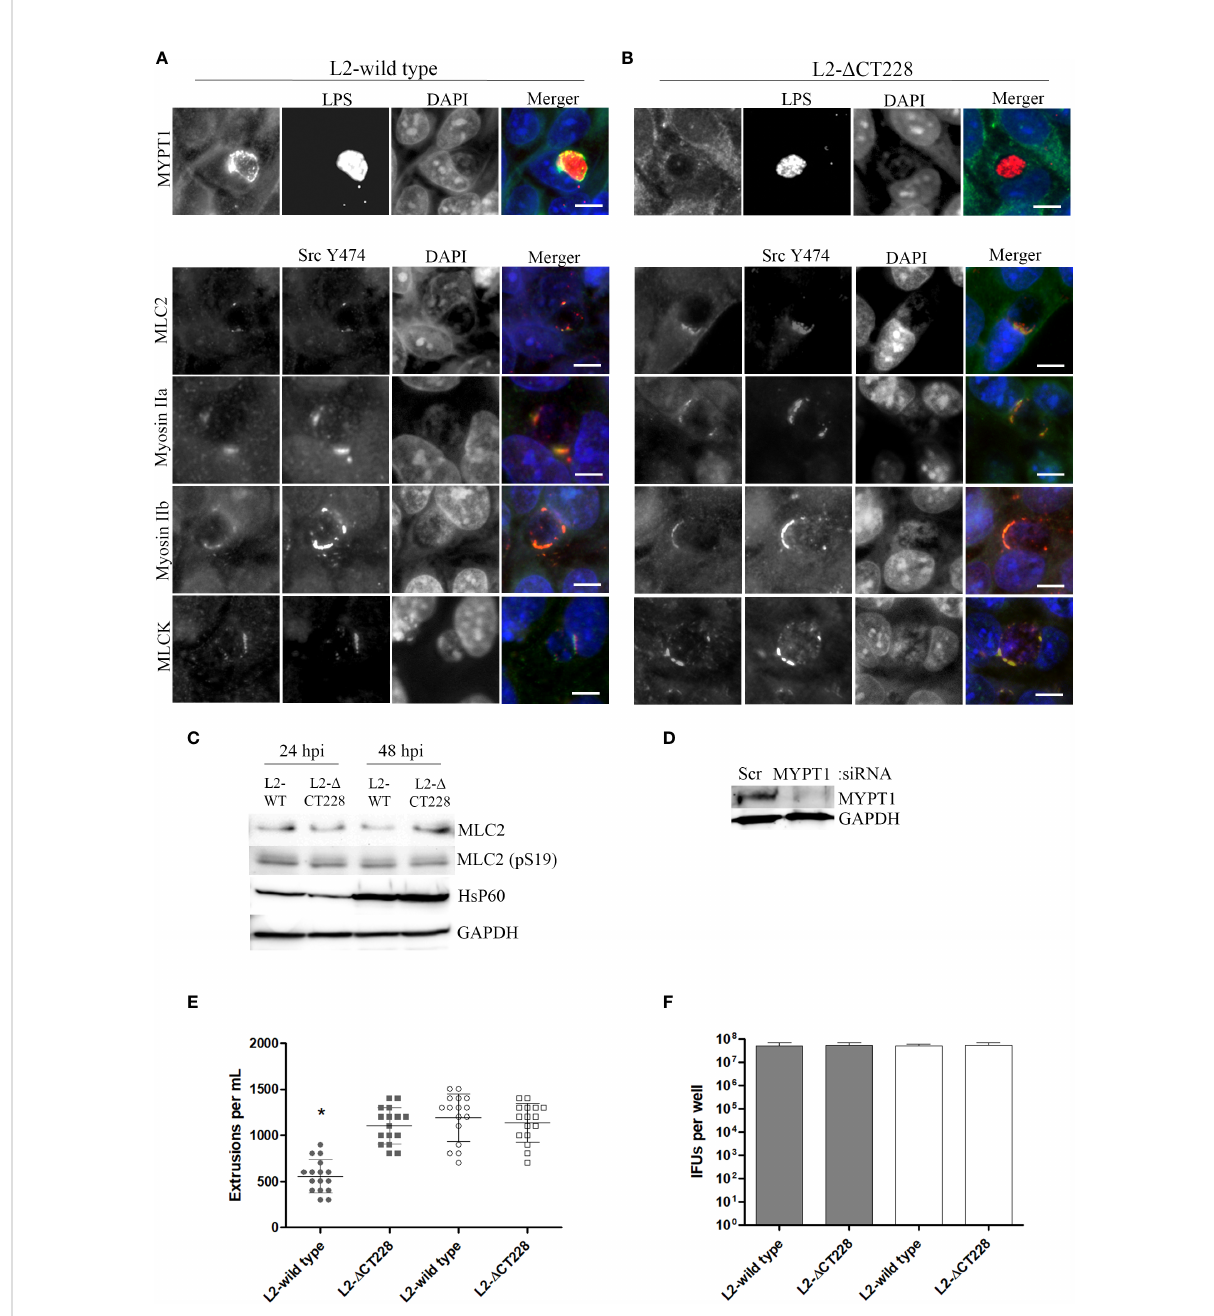
FIGURE 3 Recruitment of MYPT1 and Myosin phosphatase pathway components and extrusion production by C. trachomatis L2-wild type and L2-1CT228. HeLa cell monolayers were infected at a MOI of ∼ 0.5 with L2-wild type and L2-1CT228 for 18 h (in technical triplicate). Cells were fi xed and stained with primary antibodies to MYPT1, Chlamydia LPS, MLC2 (pS19), Src Y474, MLCK (pY471), non-muscle Myosin IIa and IIb followed by fl uorescent secondary antibodies. Experiments were repeated on three separate occasions and representative images were selected. (A, B) Top panel shows individual and merged images of MYPT1 recruitment (green) and Chlamydia LPS staining (red) in both the L2-wild type and L2- 1CT228. Lower panel of individual and merged images show MLC2 (pS19), MLCK (pY471), and Mysoin IIa and IIb (green) co-localizing with active Src Y474 kinase (red) in microdomains at the periphery of inclusions in both L2-wild type and L2-1CT228. Scale bar, 10µm. (C) Total protein from L2-wild type and L2-1CT228 infected HeLa cells at 24 and 48 h post-infection were assessed for MLC2, MLC2 (pS19), HsP60, and GAPDH levels by western blot analysis. (D) HeLa cells were treated with either Scramble (Scr) or MYPT1 siRNA for 48 h prior to infection with L2-wild type and L2-1CT228. Protein samples were assessed for MYPT1 and GAPDH levels by western blot. (E) Extrusions collected and (F) IFUs were assessed for L2 wild-type and L2-1CT228 at 48 h post-infection in either Scramble (symbols and solid bars) or MYPT1 (open symbols and white bars) siRNA treated HeLa cells. *p <